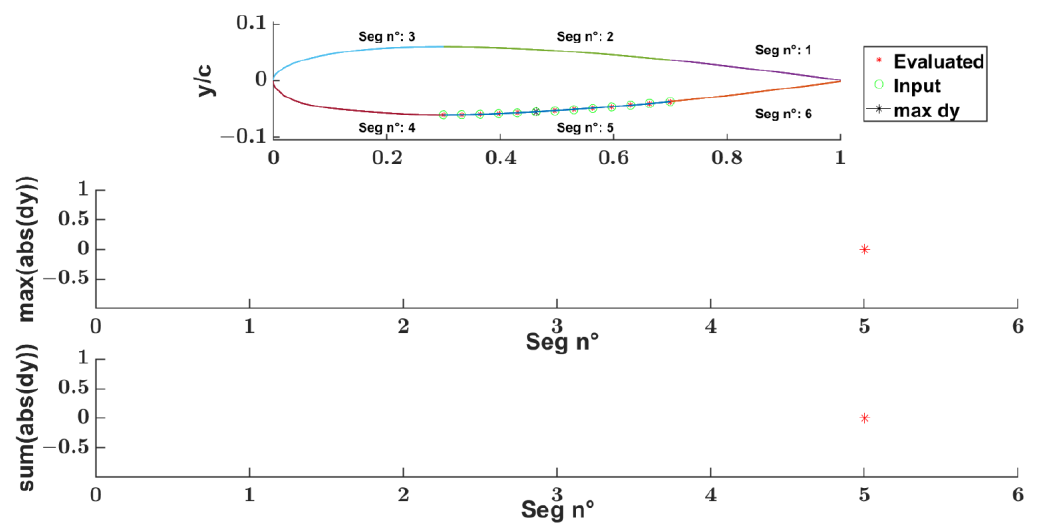
Figure 16. NACA 0012 step 2 segment 5 CPs, objective function max Euclidean distance between curve and input points.